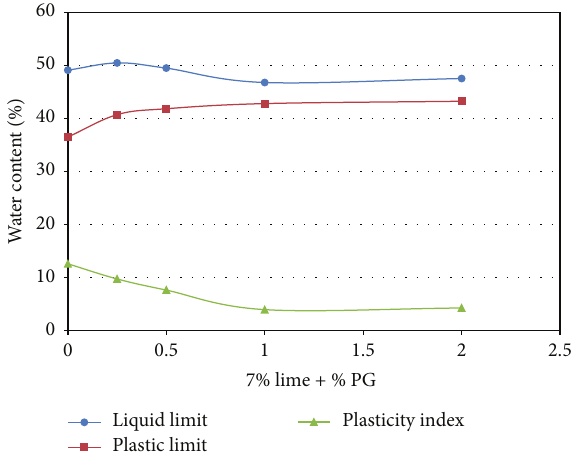
Figure 5: Effect of PG on the plasticity of 7% lime stabilized soil.